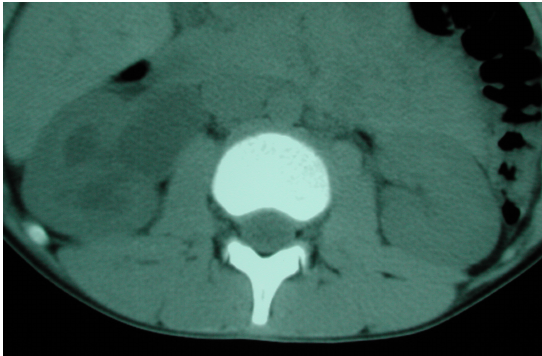
FIGURE 3 . Ureteropelvic obstruction on CT scan. Dilatation of right renal collecting